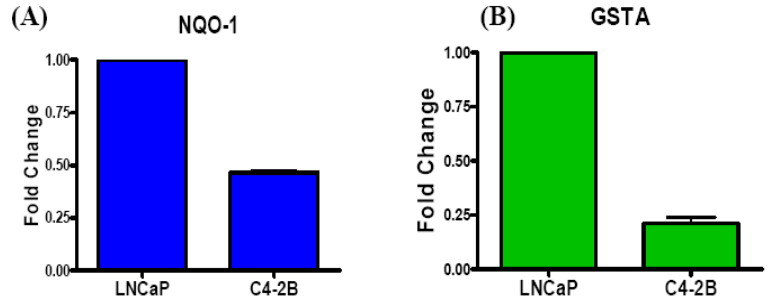
Figure 4. Differential Transcriptional Activation through the EpRE. In LNCaP and C4-2B cells. (A) an NQO-1 Luciferase reporter plasmid was transfected and (B) a GSTA Luciferase reporter plasmid (containing 6 repeats of the GSTA EpRE sequence) was transfected. After 24 h, cell extracts were obtained luc -activities were measured in a Dual Luciferase assay (Promega). A Renilla based reporter plasmid was used as the internal control (n =